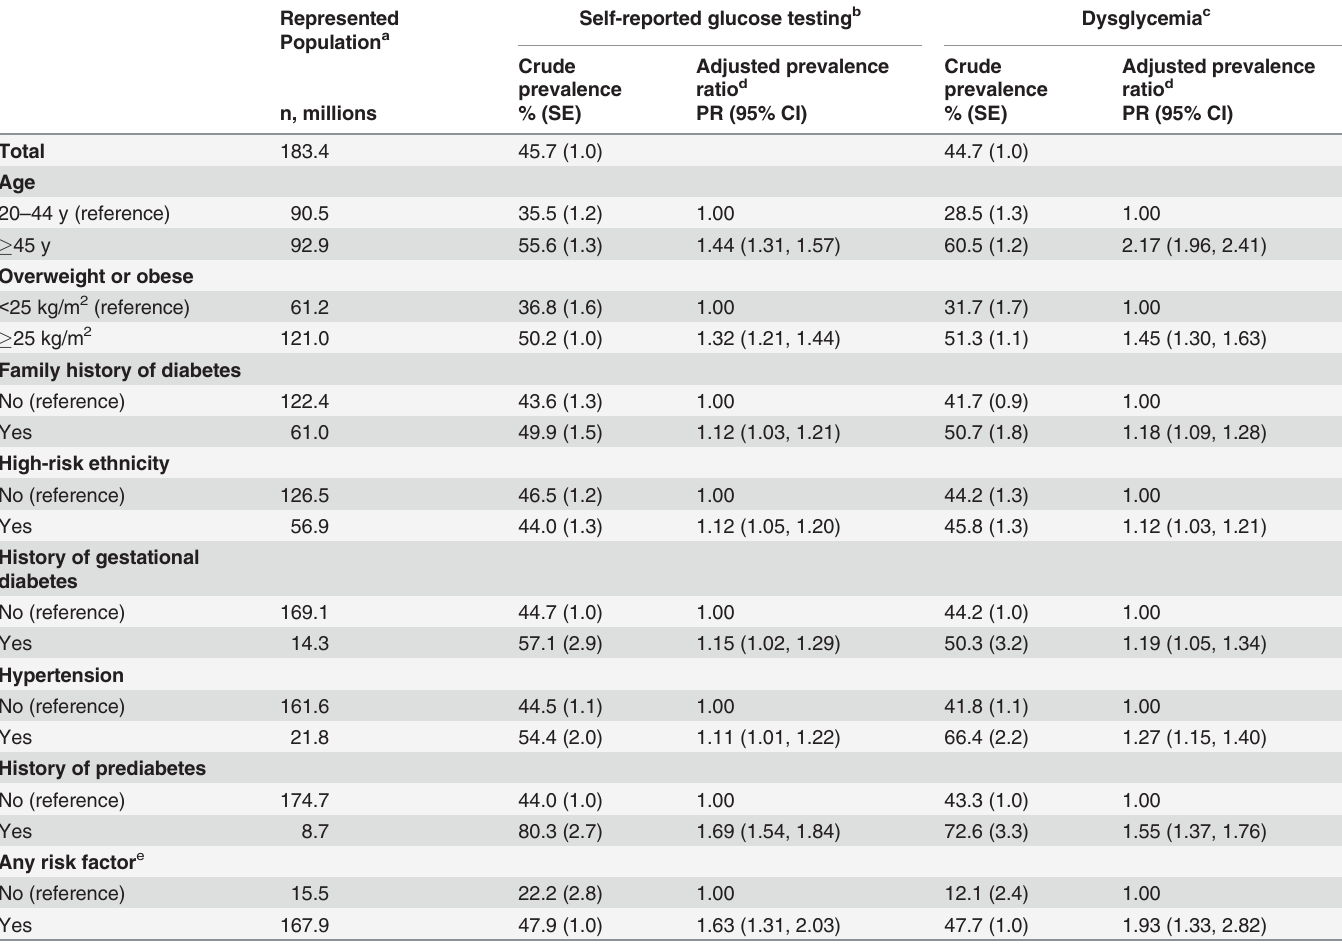
Table 3. Prevalence of self-reported receipt of glucose testing in past 3 years and dysglycemia according to selected major risk factors among US adults without diagnosed diabetes. Represented Population